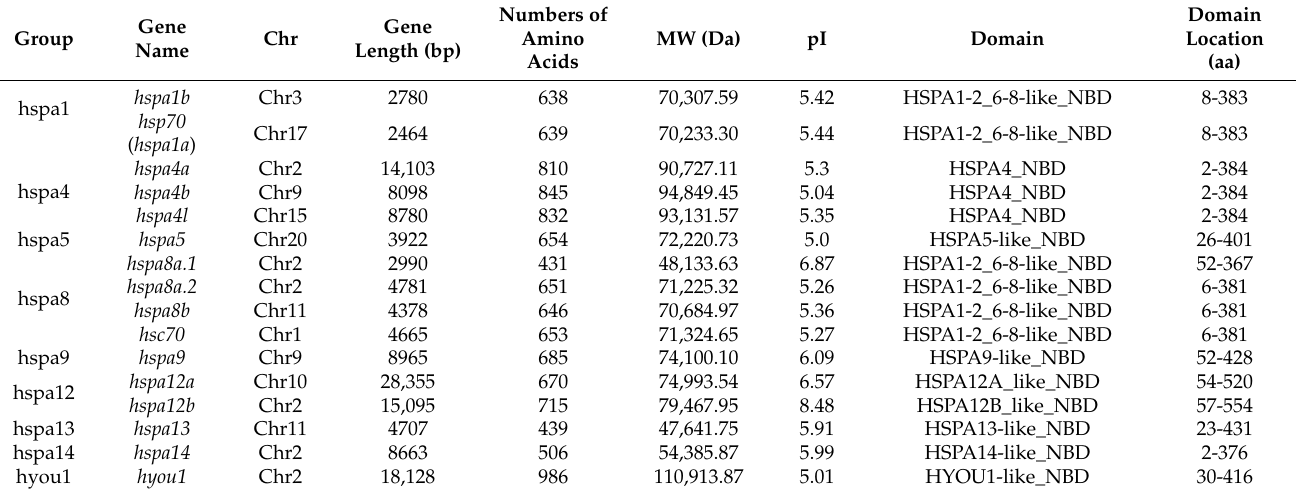
Table 1. Summary of sequence characteristics of HSP70 genes in S. maximus